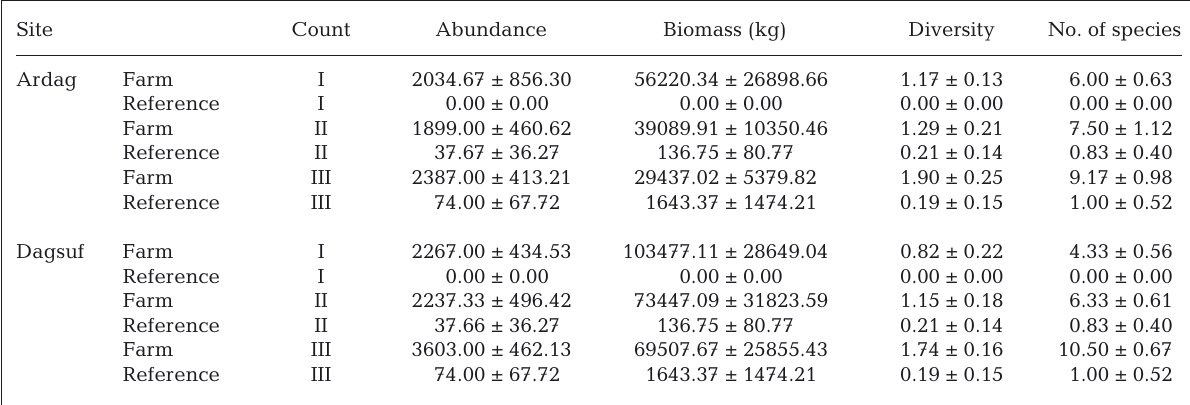
(comparison between reference and farm: p = 0.001), and also between Ardag and Dagsuf (p = 0.001).